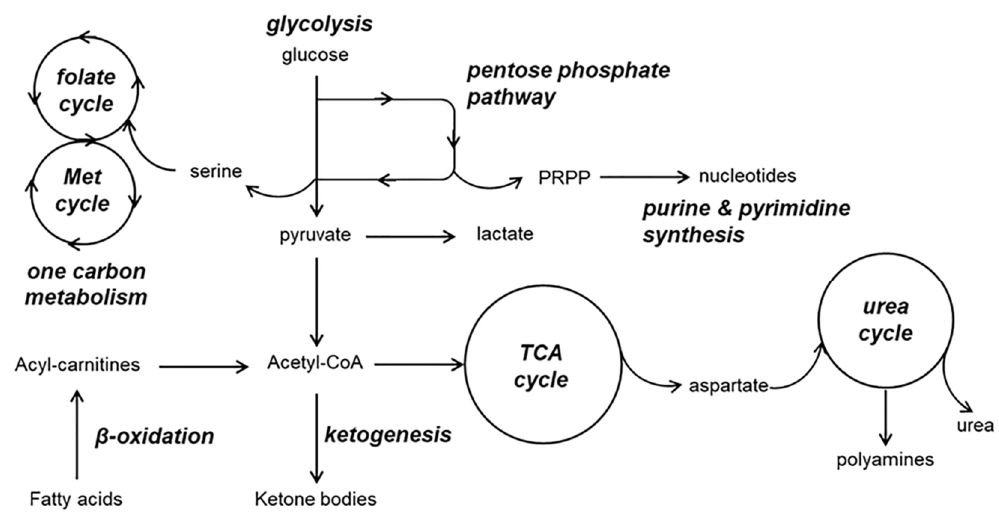
Figure 1. Overview of the central metabolic pathways altered in Alzheimer’s